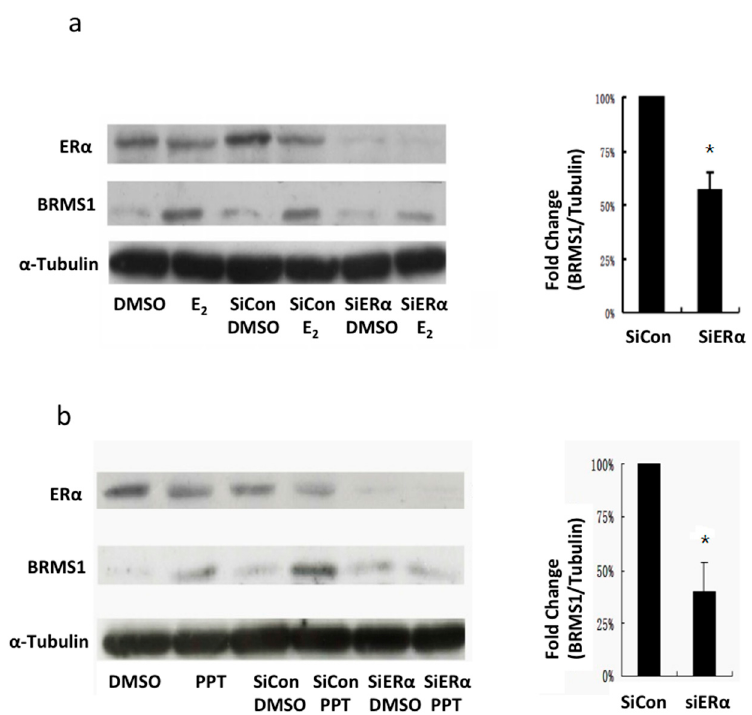
Figure 6. The effects of siER α on BRMS1 expression in MCF-7 cells after treatment with E 2 or PPT. MCF-7 cells were transfected with siER α for 48 h and then treated with either E 2 , PPT, or DMSO for 16 h. siControl cells were incubated in the same volume of transfection reagent without siER α . Each lane was loaded with 20 µ g and membranes were probed with monoclonal antibodies against ER α , BRMS1, or α -tubulin as loading control. Controls are untransfected cells treated with DMSO, PPT or E 2 . ( a ) Western blot demonstrating knockdown of ER α and corresponding BRMS1 protein expression from MCF-7 cells treated with 10 nM E 2 . The bar graph ( right panel ) summarizes BRMS1 protein normalized to α -tubulin from control and SiER α from the same lane in three independent experiments; ( b ) Western blot demonstrating knockdown of ER α and corresponding BRMS1 protein expression from MCF-7 cells treated with 10 nM PPT. The bar graph ( right panel ) summarizes BRMS1 protein normalized to α -tubulin from control and SiER α from the same lane in three independent experiments. Values with error bars were the average of three independent experiments ± SD. * indicates statistical significance at the p < 0.05, compared to siControl for E 2 or PPT treatment.